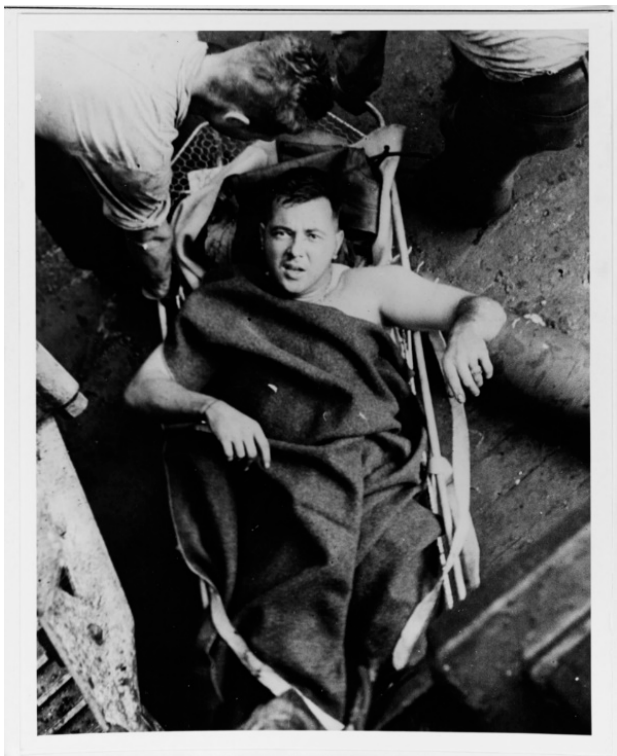
Figure 1. An Injured Man in a Stretcher on Board USS Minneapolis, 1 December 1942. National Archives photo no. 80-G-211222. Used with permission.